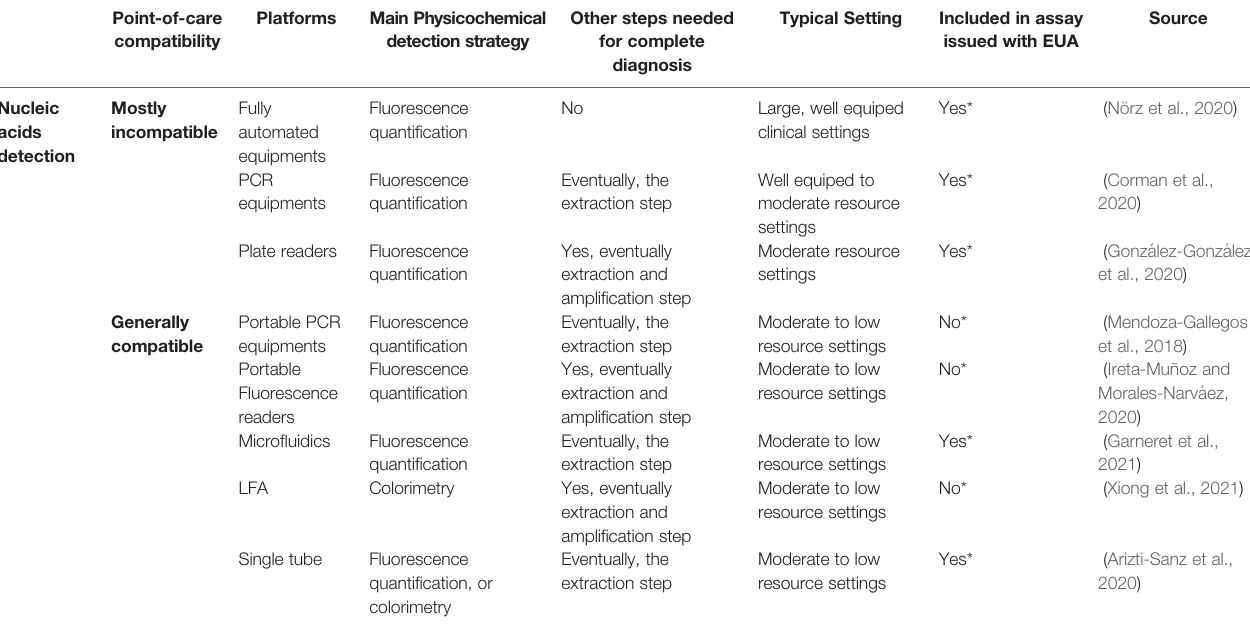
TABLE 7 | Comparison of platforms used for performing SARS-CoV-2 detection. Point-of-care